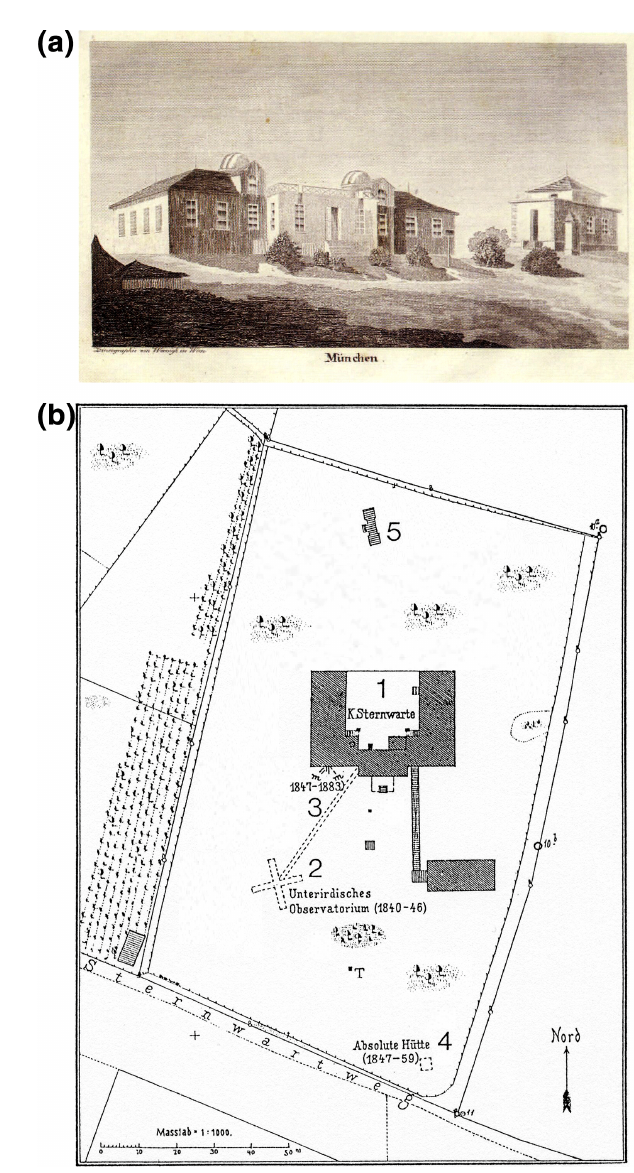
Figure 2. (a) The Astronomical Observatory in Bogenhausen; pic- ture from the mid-1840s. On the left-hand side the roof of the par- tially subsurface geomagnetic observatory can be seen. The build- ing on the right side contains the new telescope which was installed in 1834. (b) Plan of the Astronomical Observatory with the build- ings and sites for geomagnetic measurements between 1840 and 1879, the time during which Johann von Lamont was its director. (1) Main building. (2) Partially subsurface observatory from 1840 to 1846. (3) Position of the instruments for the measurements of D , H and I between 1847 and 1883. (4) Building for absolute mea- surements between 1847 and 1859. (5) Building for absolute mea- surements between 1859 and